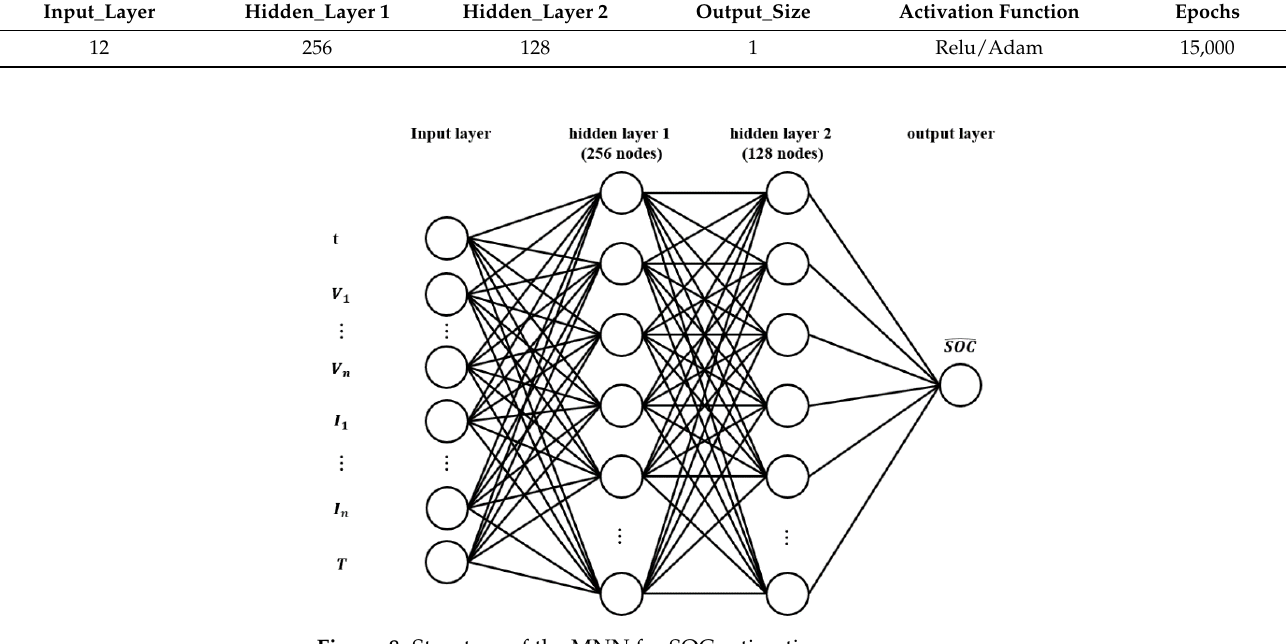
Figure 8. Structure of the MNN for SOC estimation.